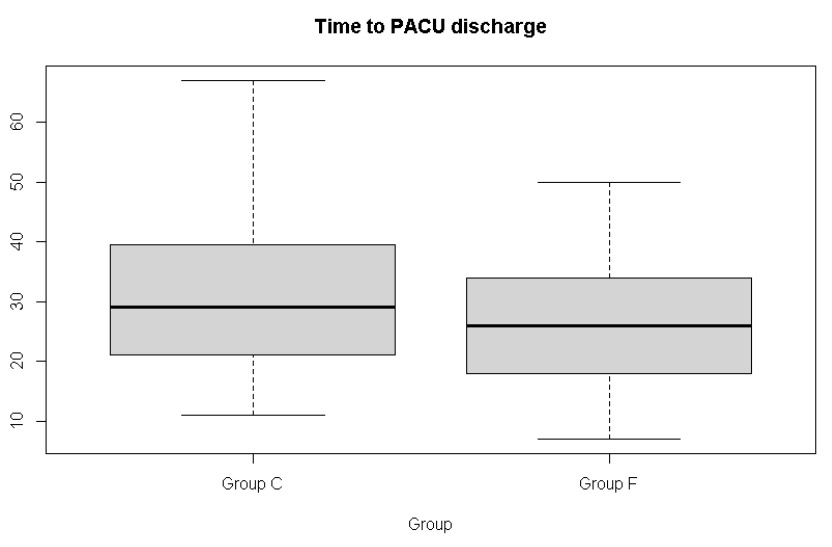
Figure 4. Box and whisker plot showing time to PACU discharge in the control group and the flumazenil group. The median is represented as a line located in the middle of the box. The top and bottom of the box are the 75th and 25th percentiles, respectively, and the ends of the whiskers are the ±1.5 × interquartile range.